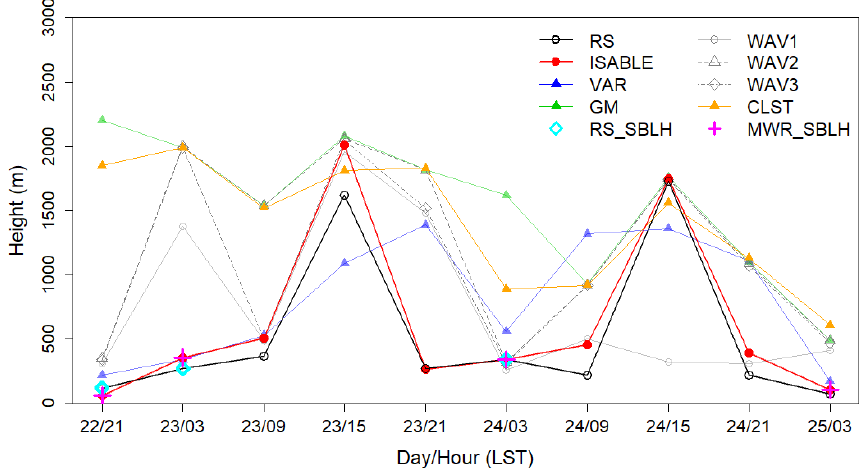
Figure 9. Time series of the ABLH estimated via radiosonde, ISABLE, VAR, GM, WAV1, WAV2, WAV3, and CLST methodologies from 21:00LST on 22 September 2016 to 03:00LST on 25 September 2016. The SBLHs, estimated via radiosonde (RS_SBLH) and microwave radiometer (MWR_SBLH), are indicated at